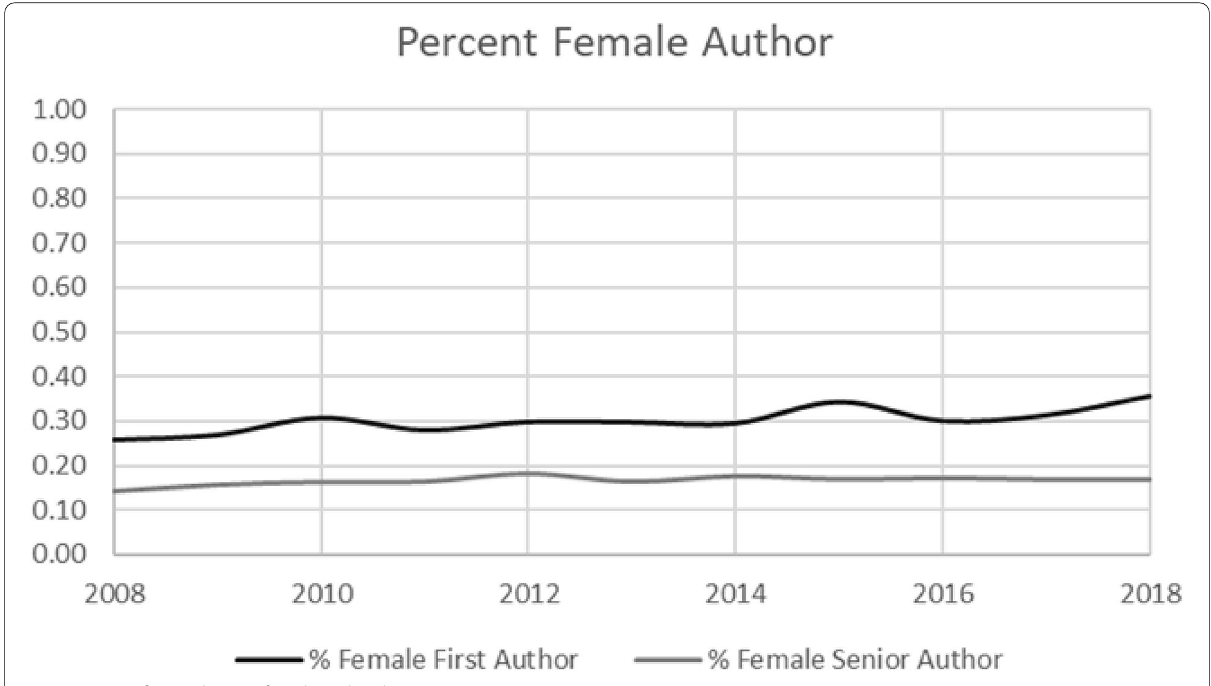
Fig. 2 Percent first and senior female authorship over